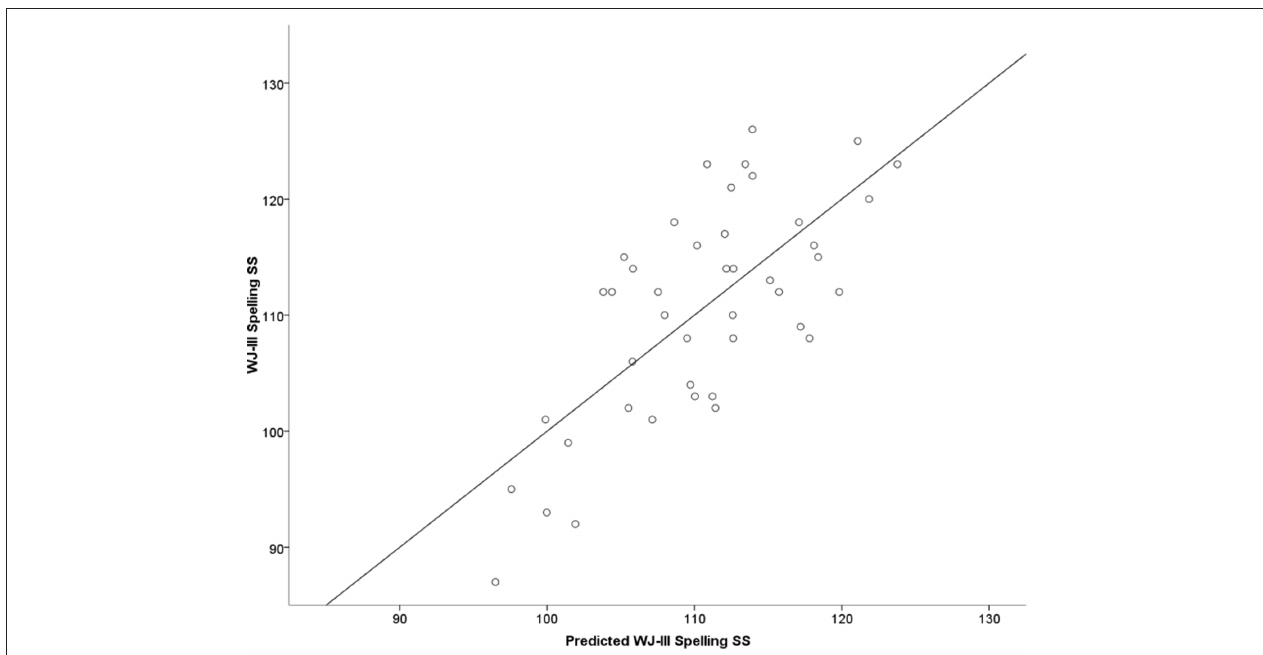
and peak latency in the left MTL and VOC among NI students (Adj. R 2 = 0.39). The regression model is described by the following